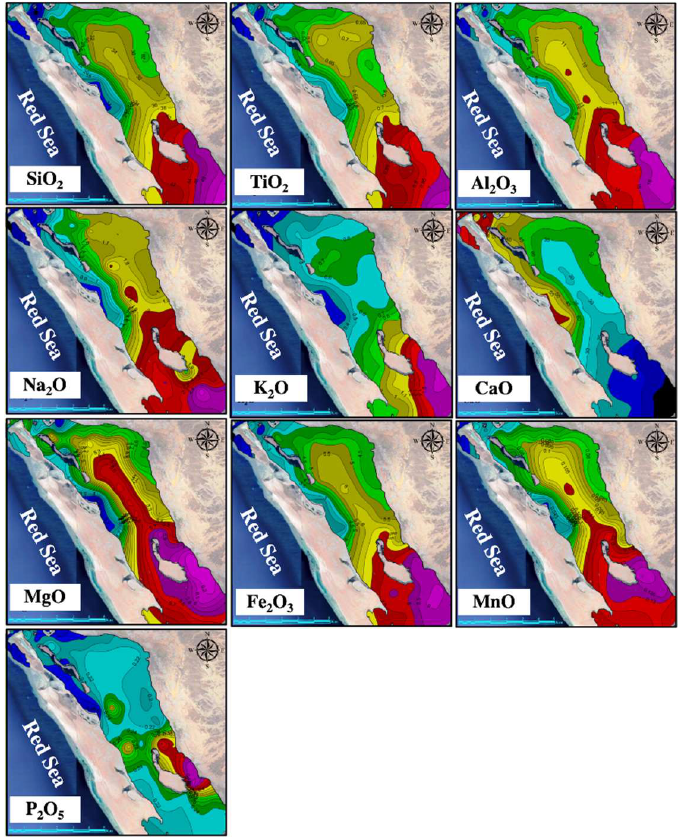
Figure 3. Contour maps showing the spatial distribution of the concentrations of oxides (%) in the bottom sediments of the Sharm Al-Kharrar. Light blue scale bar on maps equals 6 km.